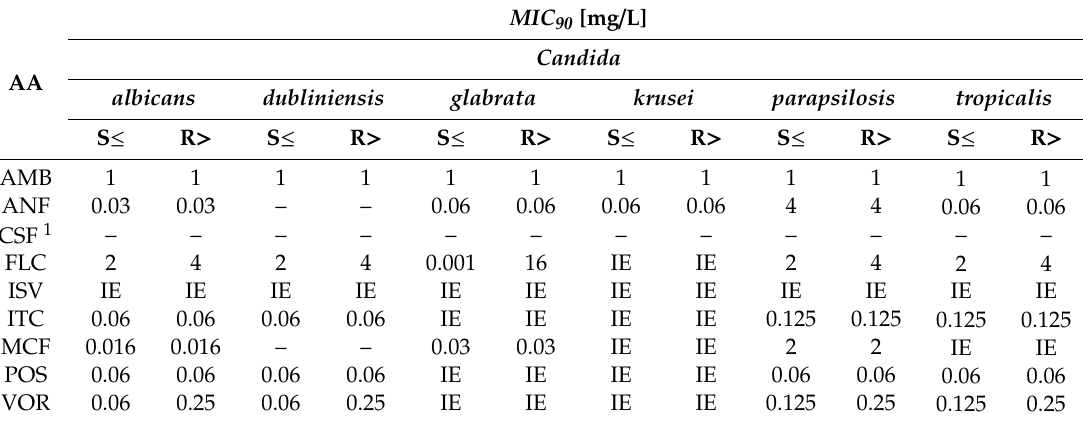
Table 5. The susceptibilities of antifungal drugs against selected Candida species are expressed as MIC 90 [mg/L]. AA = antifungal agent, IE = insufficient evidence.